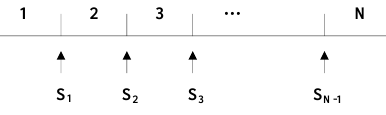
Figure 1. An example of